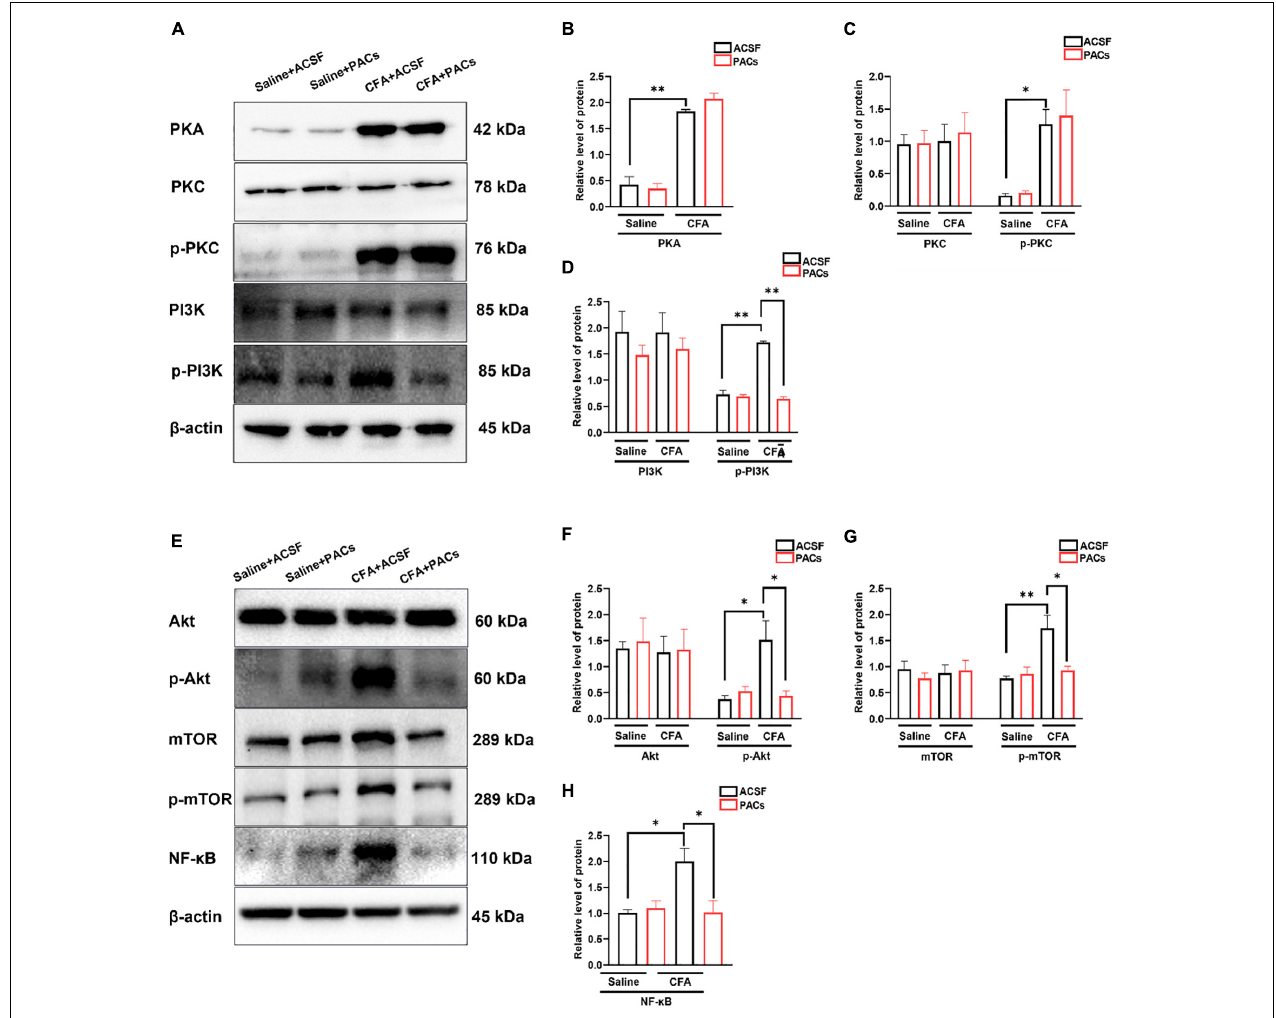
FIGURE 6 | The role of proanthocyanidins in the PI3K/Akt/mTOR signaling pathway. (A) Representative bands of PKA, PKC/p-PKC, and PI3K/p-PI3K. (B–D) Application of proanthocyanidins reversed the activation of p-PI3K but not PKA, PKC/p-PKC, or PI3K in the CFA group. (E) Representative bands of Akt/p-Akt, mTOR/p-mTOR, and NF- κ B. (F–H) Application of proanthocyanidins reversed the activation of p-Akt, p-mTOR, and NF- κ B but not Akt and mTOR in the CFA group. ∗ P < 0.05; ∗∗ P < 0.01. CFA, Complete Freund’s Adjuvant; ACSF, artificial cerebrospinal fluid; PACs,